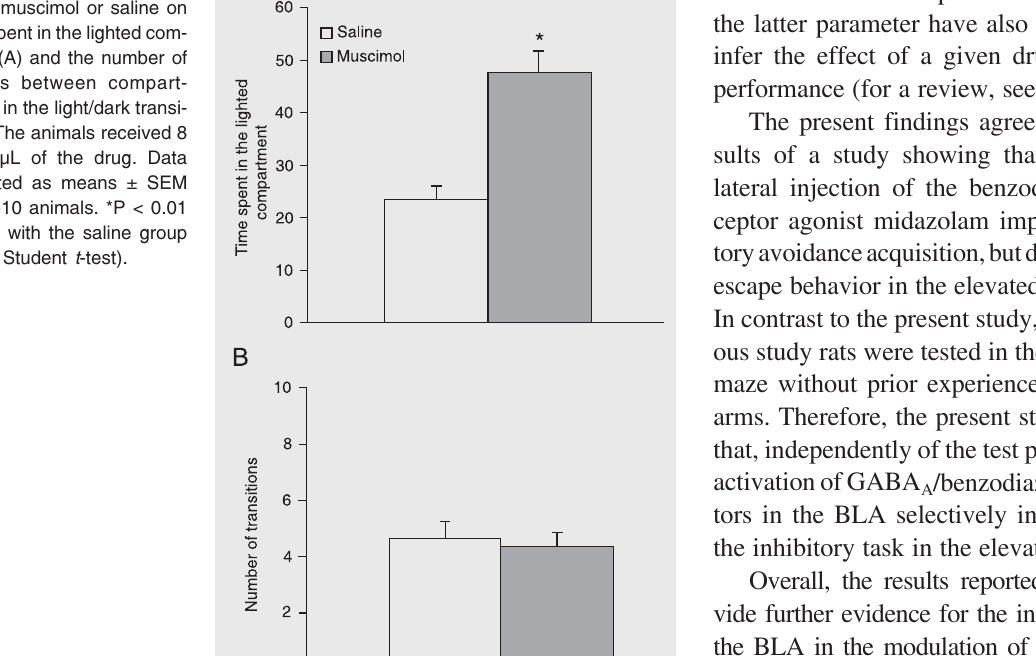
Figure 2. Effect of intra-basolat- eral nucleus of the amygdala in- jection of muscimol or saline on the time spent in the lighted com- partment (A) and the number of transitions between compart- ments (B) in the light/dark transi- tion test. The animals received 8 nmol/0.2 µL of the drug. Data are reported as means ± SEM for N = 9-10 animals. *P <